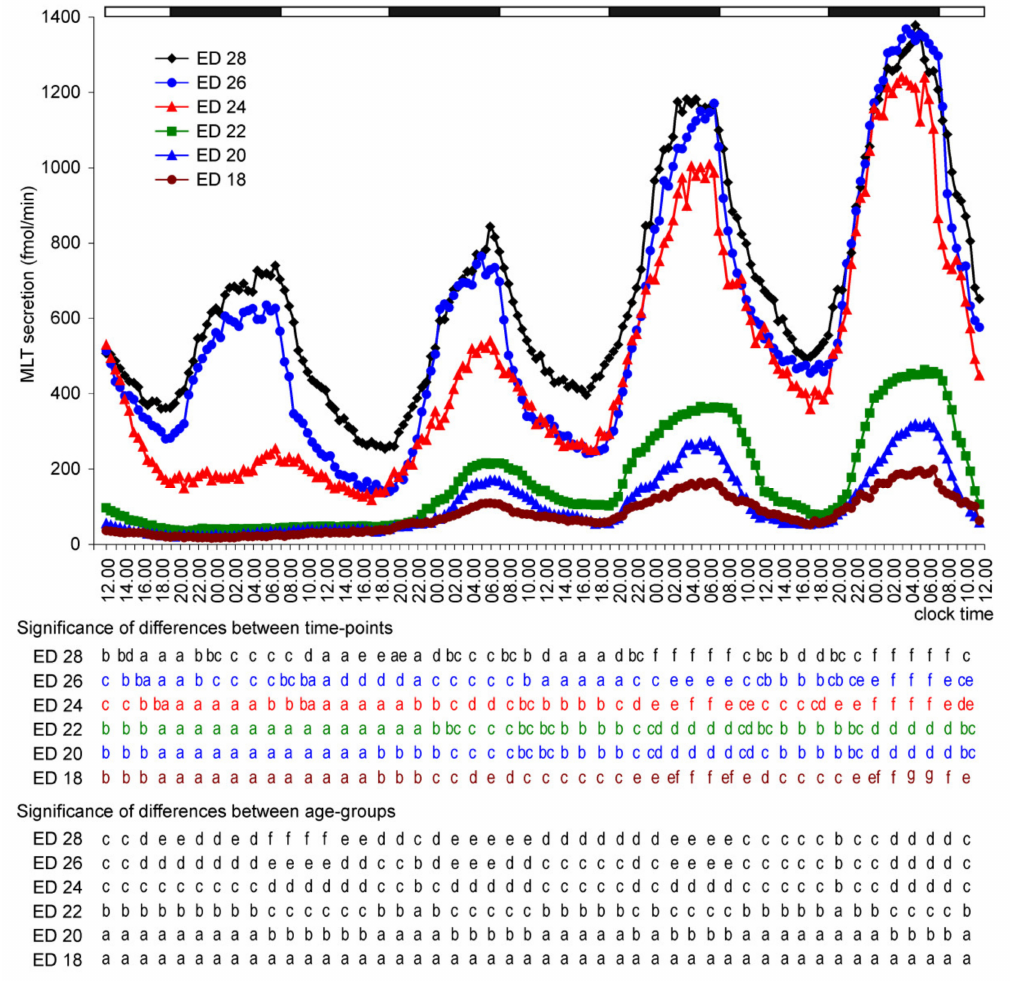
Figure 1. Secretion of MLT (means, n = 4) from pineal organs of goose embryos incubated under a 12L:12D cycle (photophase from 07.00 to 19.00). Color letters show differences between time-points within a group of explants prepared from embryos of the same age, and black letters show differences between these groups at the same time-point. The identical letters indicate means, which are not significantly